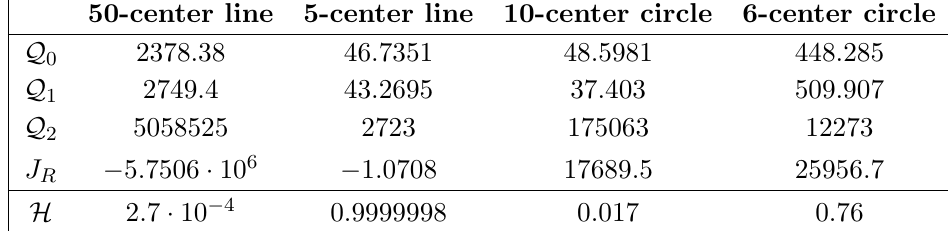
Table 3 . Asymptotic charges and angular momenta of the solutions for (cid:22) =